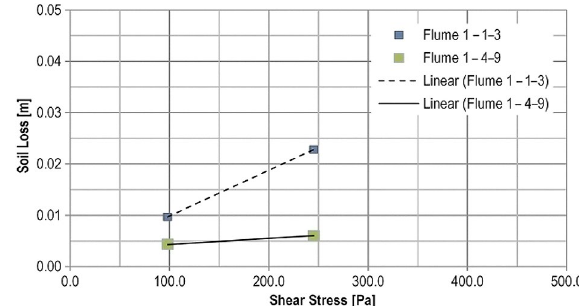
Fig. 13. Erosion rates flume 1 (unvegetated); soil loss and shear stress, steep trend line = high erosion rate, focus on the upper (“1–3”) and lower (“4–9”) flume parts, September 2014